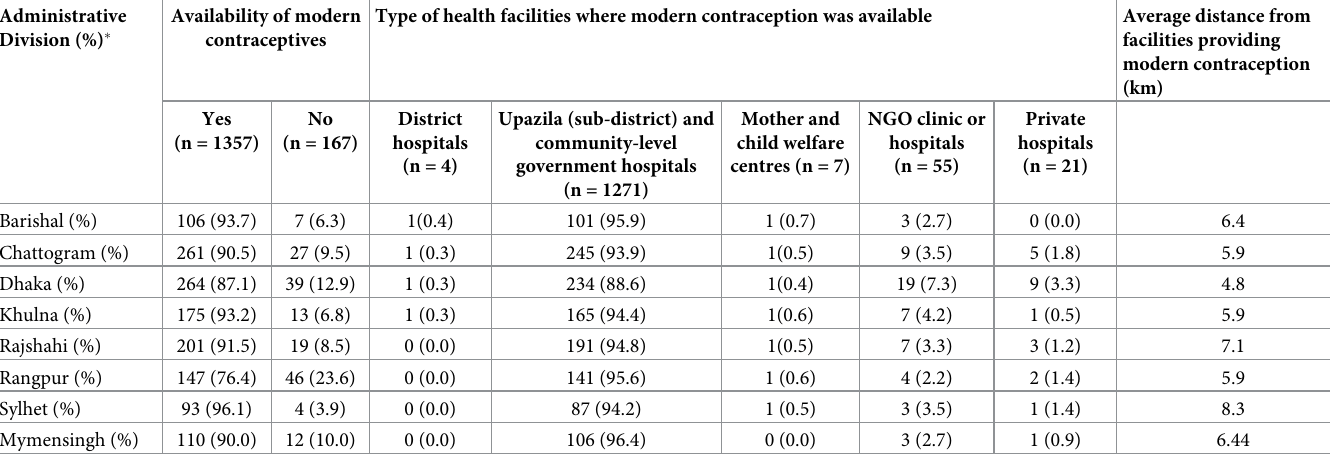
Table 2. Distribution of health facilities that delivered modern contraception and their average distance from the clusters. Administrative Division (%)